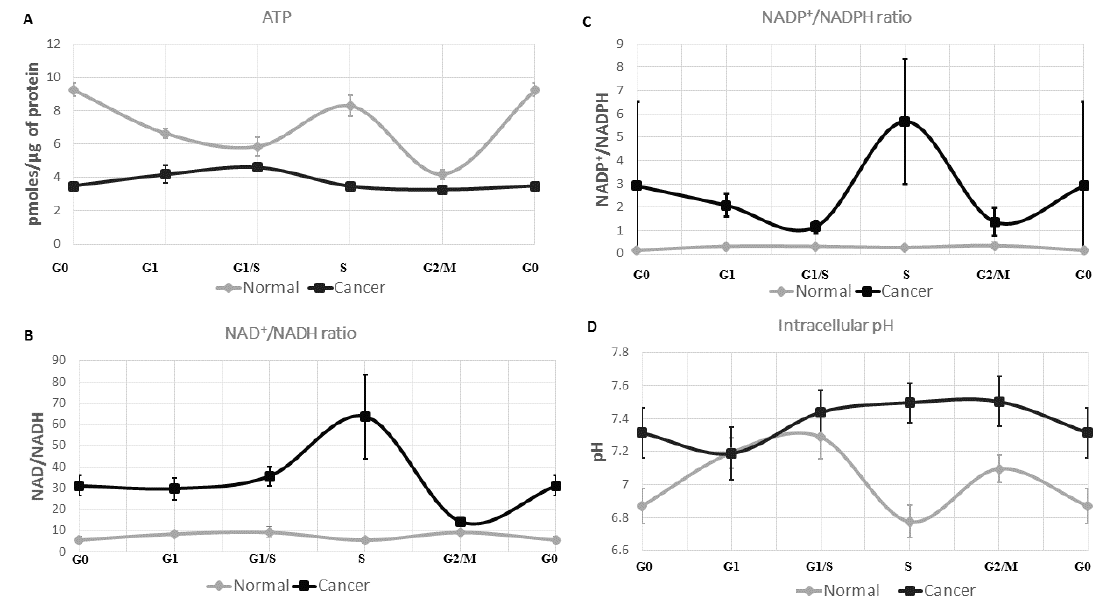
Figure 3. Redox signatures of normal and cancer cells during cell cycle progression. ( A ) In normal cells, the ATP concentration oscillates during the cell cycle: it is high in G0 (9.25 ± 0.40 pmoles/ µ g of protein) and S (8.29 ± 0.62 pmoles/ µ g of protein) and lower in G1/S (5.85 ± 0.57 pmoles/ µ g of protein) and G2/M (4.18 ± 0.29 pmoles/ µ g of protein). In cancer cells, ATP concentration is about twice lower in G0 (3.49 ± 0.25 pmoles/ µ g of protein), slightly increases from G0 to G1/S (4.6 ± 0.19 pmoles/ µ g of protein), and decreases from G1/S to G2/M (3.25 ± 0.11 pmoles/ µ g of protein); ( B ) in normal cells, the NAD + /NADH ratio oscillates between 5 and 10. For the cancerous cell line, the ratio increases from G0 (31.03 ± 1.54) and reaches a maximum value of 55 in S. Then, it declines at the G2/M transition (14); ( C ) the NADP + /NADPH ratio slightly increases from G0 (0.13 ± 0.05) to G1 (0.32 ± 0.04) in the normal cell population and stays stable. For the cancer cell population, a major peak is observed in S (5.68 ± 2.68); and ( D ) the intracellular pH (pHi) of cancer cells is alkaline and globally more acidic for normal cells. It oscillates from G0 (pH = 6.87 ± 0.10) to G1/S (pH = 7.29 ± 0.13), and then shows a marked decrease in S (pH = 6.78 ± 0.10). The cancerous cell population loses the pHi drop in the S phase and is much more alkaline (pH = 7.50 ± 0.12).